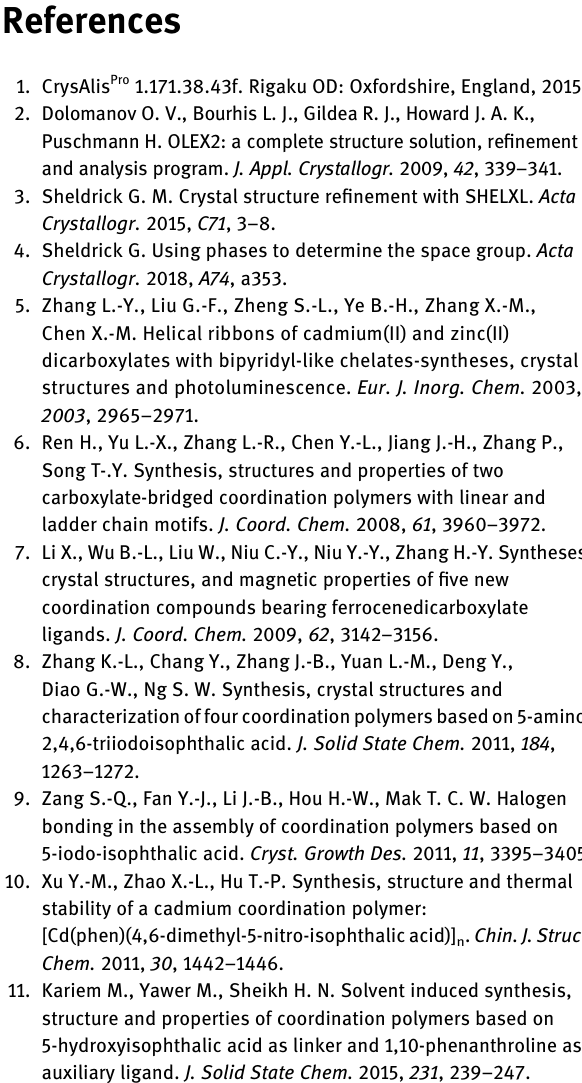
2-hydroxybenzene-1,3-dicarboxylate anions to generate 1D structure, further forming a 3D supramolecular structure by π / π weak interaction of 1,10-phenanthroline molecules. The